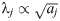
Increasing the number of synaptically driven dendrites can decrease the firing rate when the axon, of radius aα is much thinner than the dendrite, radius a1.The length constant for each neurite is proportional to the square root of the radius λj∝aj. (a) λα = 100μm, (b) λα = 150μm, (c) The number nmax of dendrites that maximizes firing increases with higher ratios of axon-to-dendrite radii aα/a1 and μ, (d) λα = 100μm, λ1 = 200μm for n = 1 and λ1 is rescaled for larger n to keep the input conductance equal to the n = 1 case. Other parameters: λ1 = 200μm (a-c, kept constant with μ by adjusting a1, Eq S42, a1(μ = 11)/a1(μ = 8) ≈ 1.05), τ1 = 10ms, τα = 11.3—11.9ms (calculated from Eq S39), σs = 3mV, vth = 10mV and xth = 30μm down the axon.